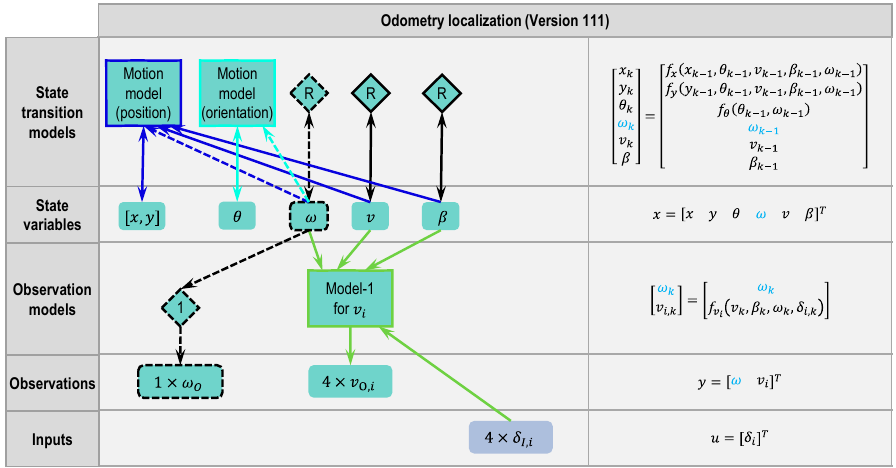
Figure 8. Modular approach to designing a state estimator for odometry localization (Version 111 based on basic version, changes marked with dashed lines or dashed blocks and blue letters, re- spectively).